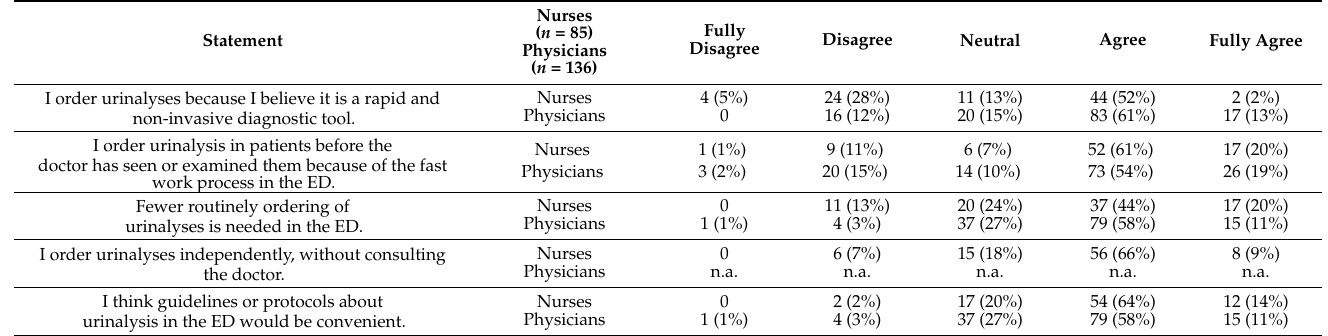
Table 4. Work process factors related to inappropriate urine testing.